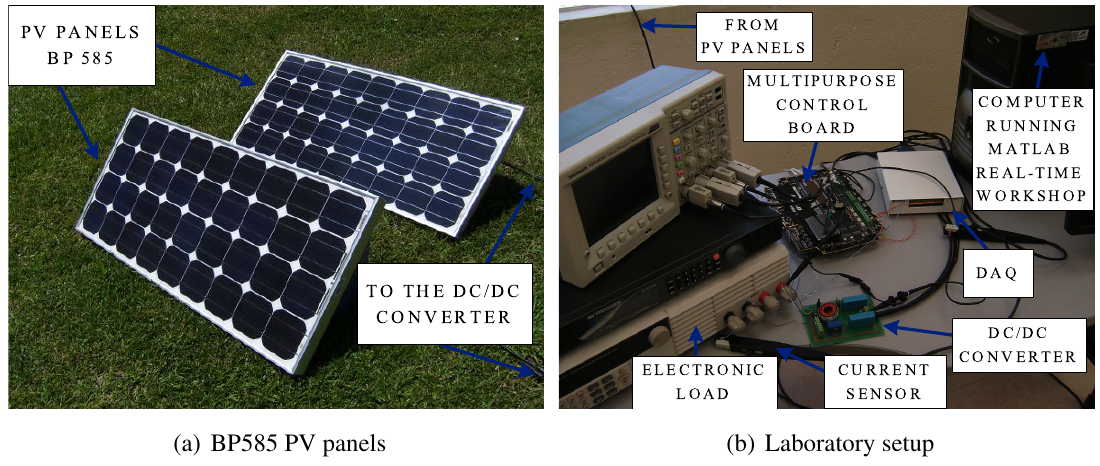
Figure 18. Experimental test bench.